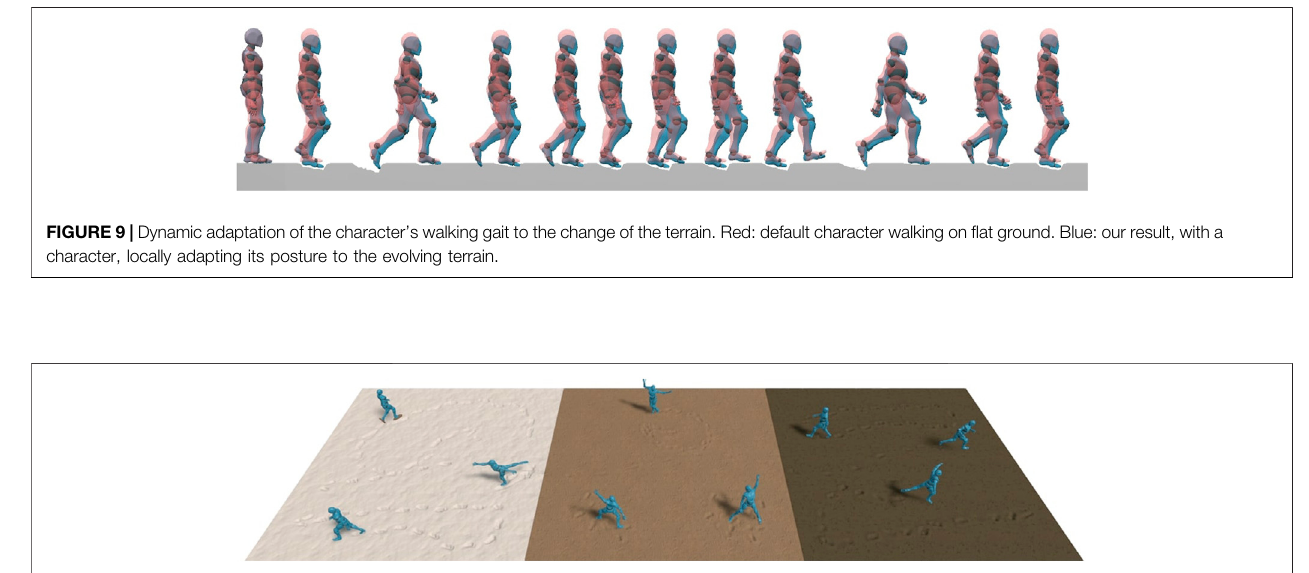
FIGURE 10 | Various kinematics motion inputs lead to plausible terrain